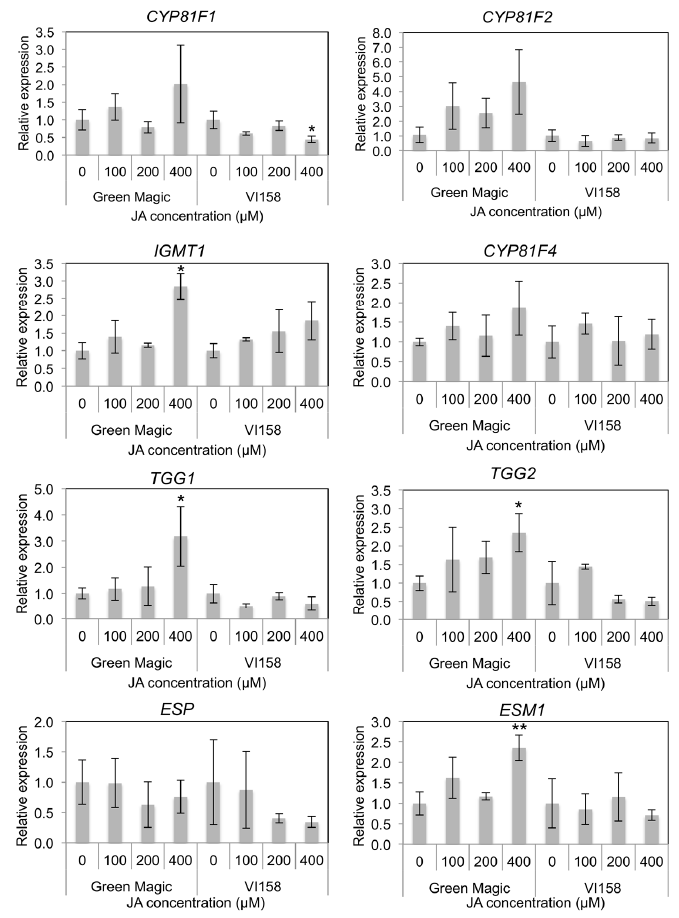
Figure 4. Histograms representing changes in relative transcript abundance of glucosinolate side chain modification, and hydrolysis related genes for different cultivar/treatment combinations. Asterisks indicate significant differences from the control within the same cultivar determined by Student’s t -test at p = 0.05 (*) and p = 0.01 (**), respectively.